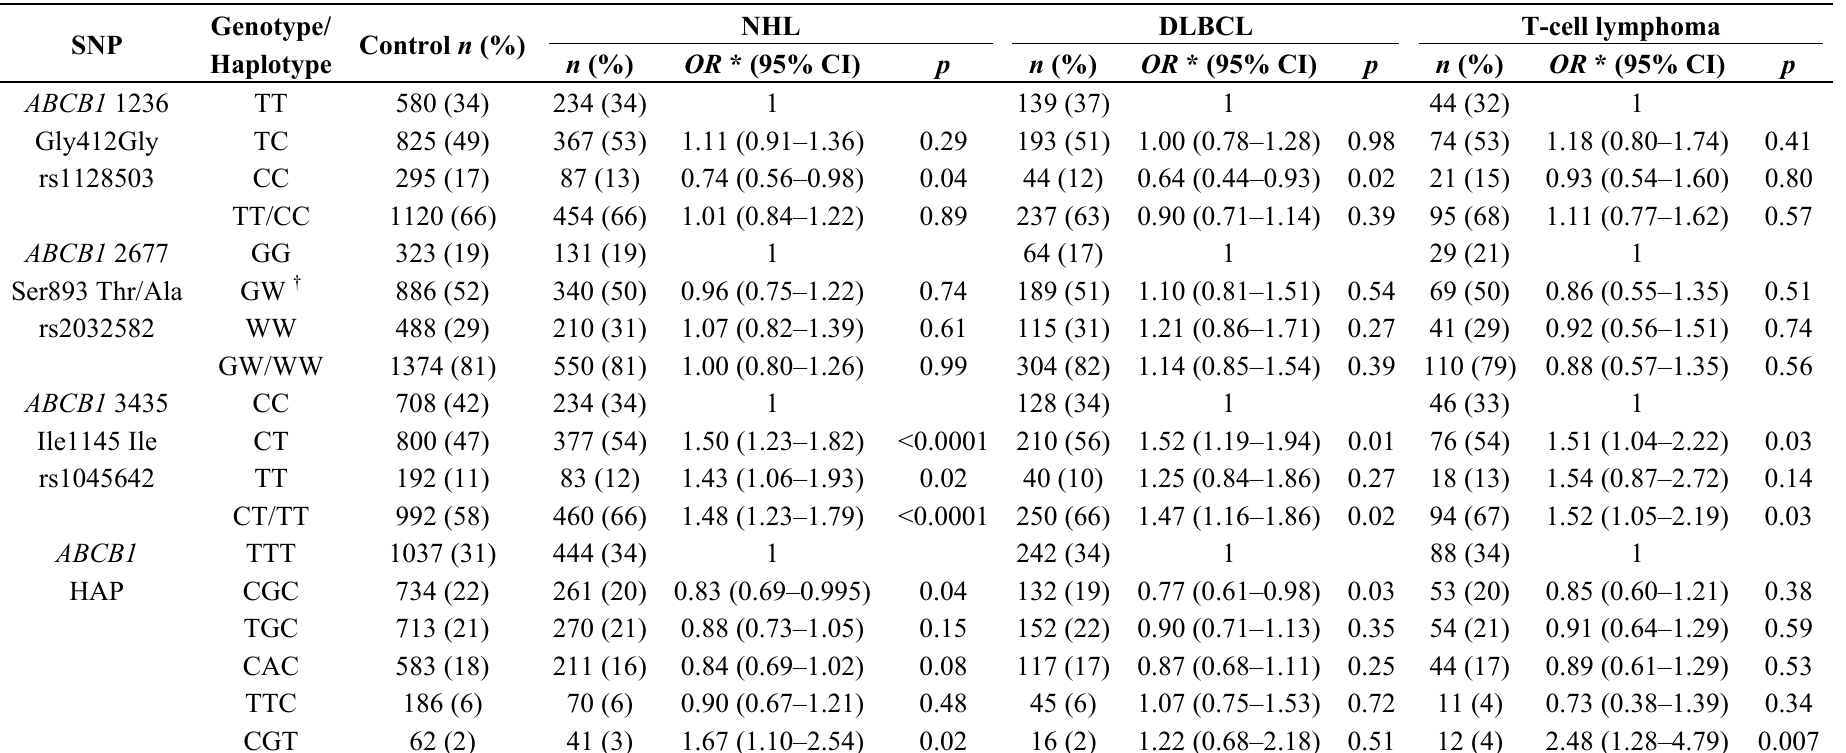
Table 3. Associations between polymorphisms in MDR1 and the risk for